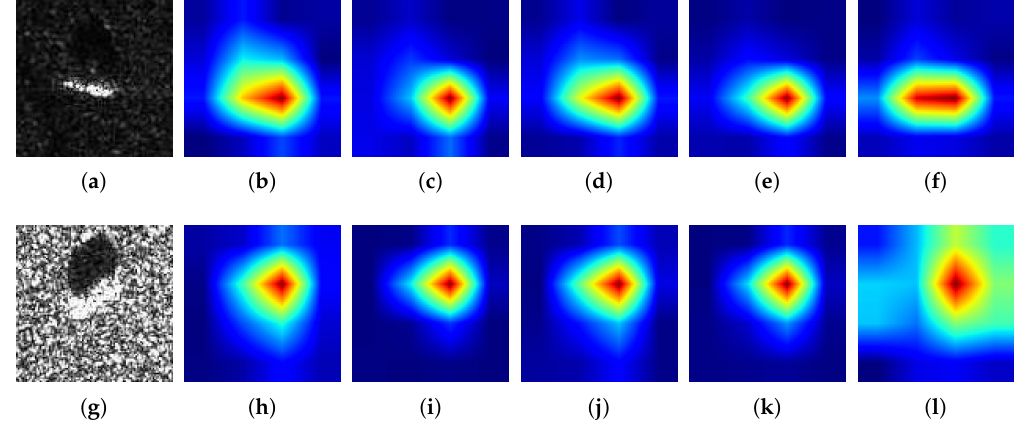
Figure 1. Comparison of various CAM heatmaps. ( a ) SAR image of a BRDM-2 armored reconnaissance vehicle. ( g ) SAR image of a BTR-60 wheeled armored carrier. ( b , h ) Grad-CAM. ( c , i ) Grad-CAM++. ( d , j ) XGrad-CAM. ( e , k ) Ablation-CAM. ( f , l )